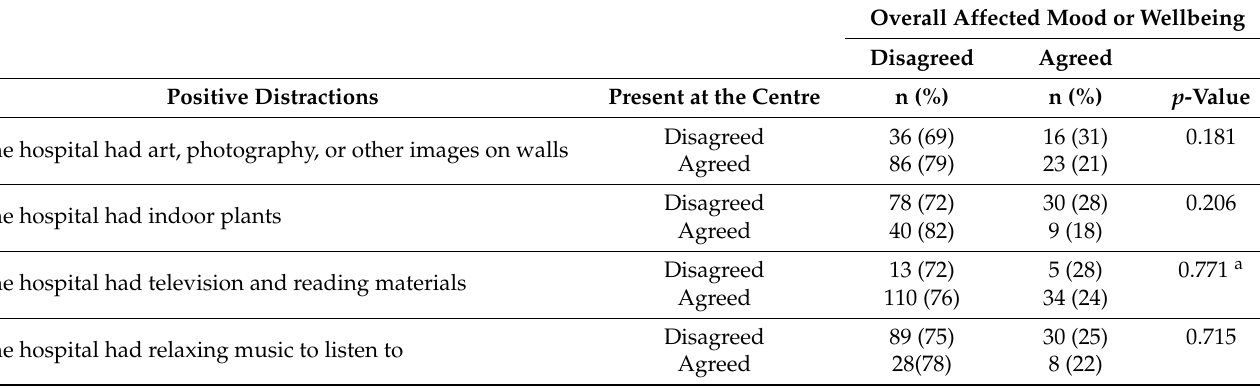
Table 4. Patient perceptions of hospital elements related to Positive Distractions and univariate associations with self- reported mood or well-being related to the overall treatment environment ( n = 165).